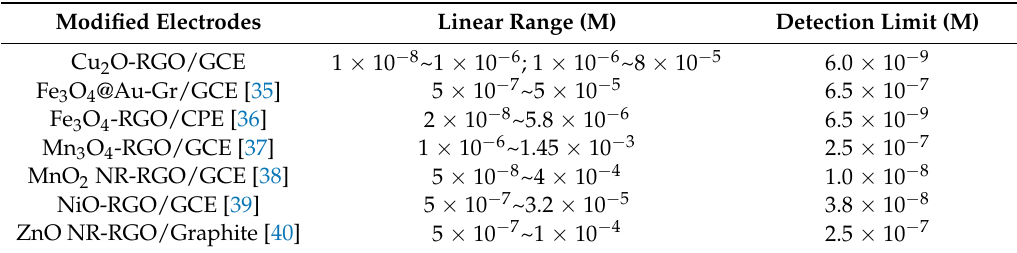
Table 1. Comparison the determination of DA between Cu 2 O-RGO/GCE and modified electrodes reported in the literature.